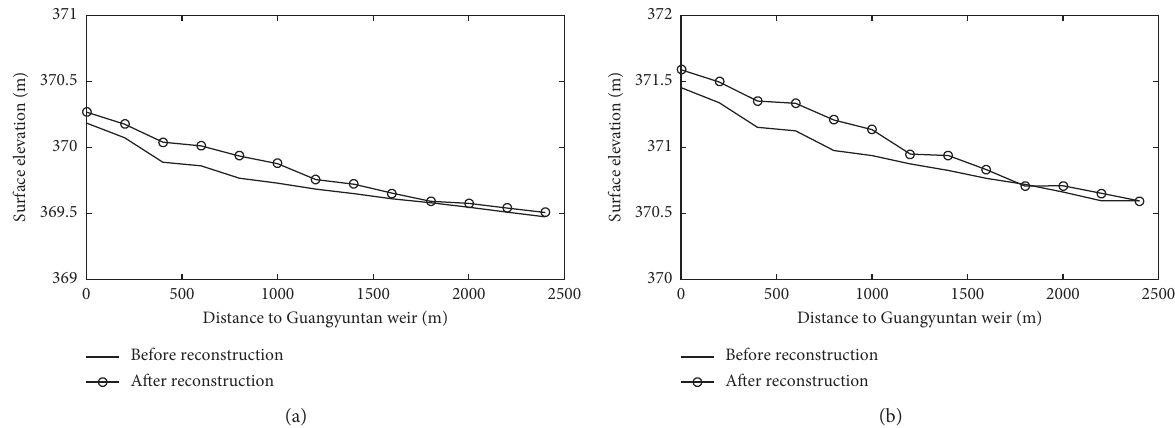
Figure 6: Comparisons of flood water surfaces along the river channel before and after river reconstruction. (a) 10-year flood. (b) 100-year flood.